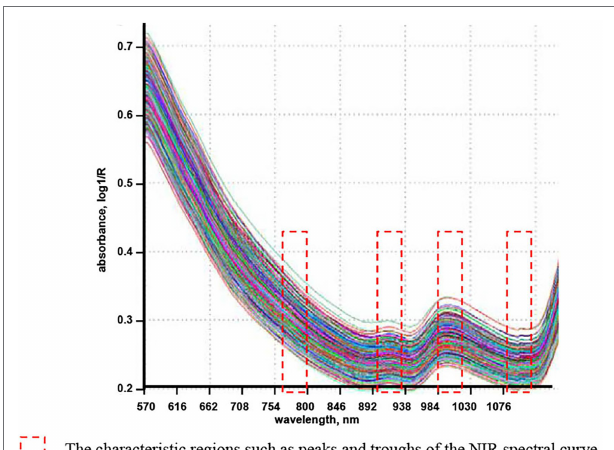
FIGURE 1 | The NIR spectrum of the